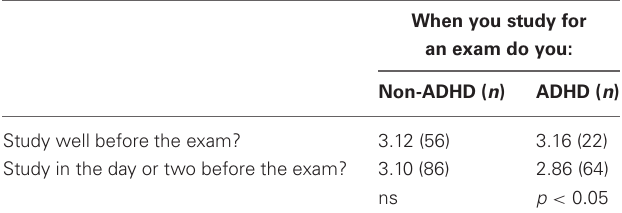
Table 1 | GPA as a function of study habits in ADHD and Non-ADHD undergraduates.